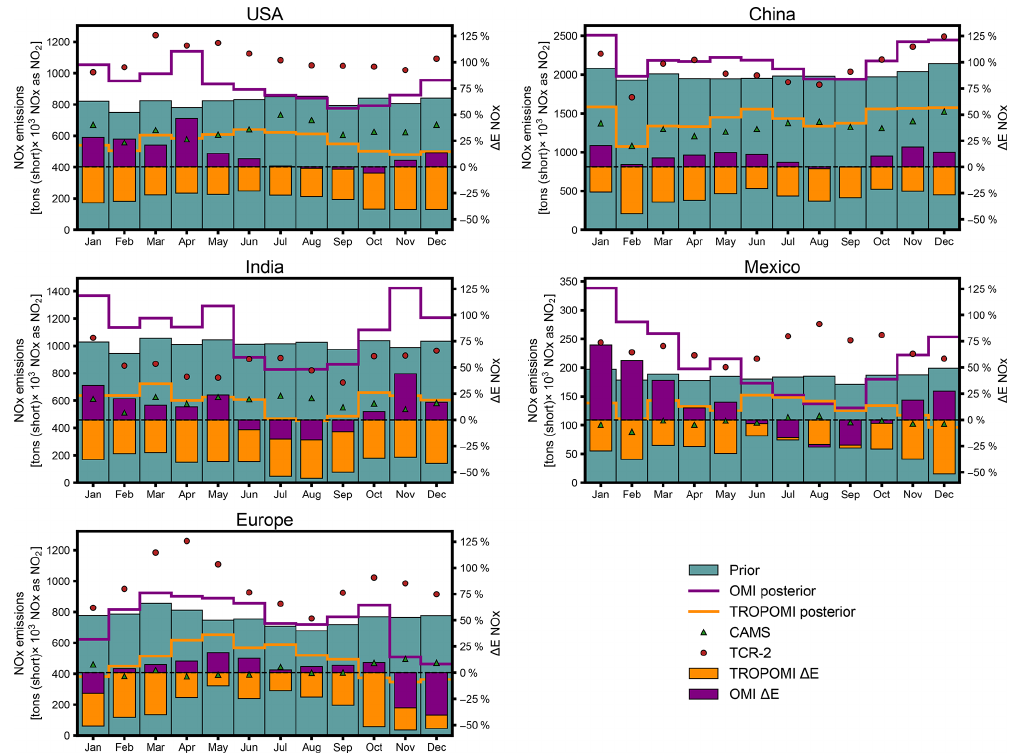
Figure 8. Monthly prior and satellite-inferred anthropogenic NO x emissions in 2019 in select global regions. Total monthly emissions (as NO 2 ) from prior emissions estimates, inference with OMI or TROPOMI observations (OMI and TROPOMI posterior), and CAMS or TCR- 2 inventories in the US, China, India, Mexico, and Europe are shown. Percent changes ( (cid:49)E NO x ) inferred with OMI or TROPOMI data, relative to prior emissions estimates, for each region are shown by the purple and orange